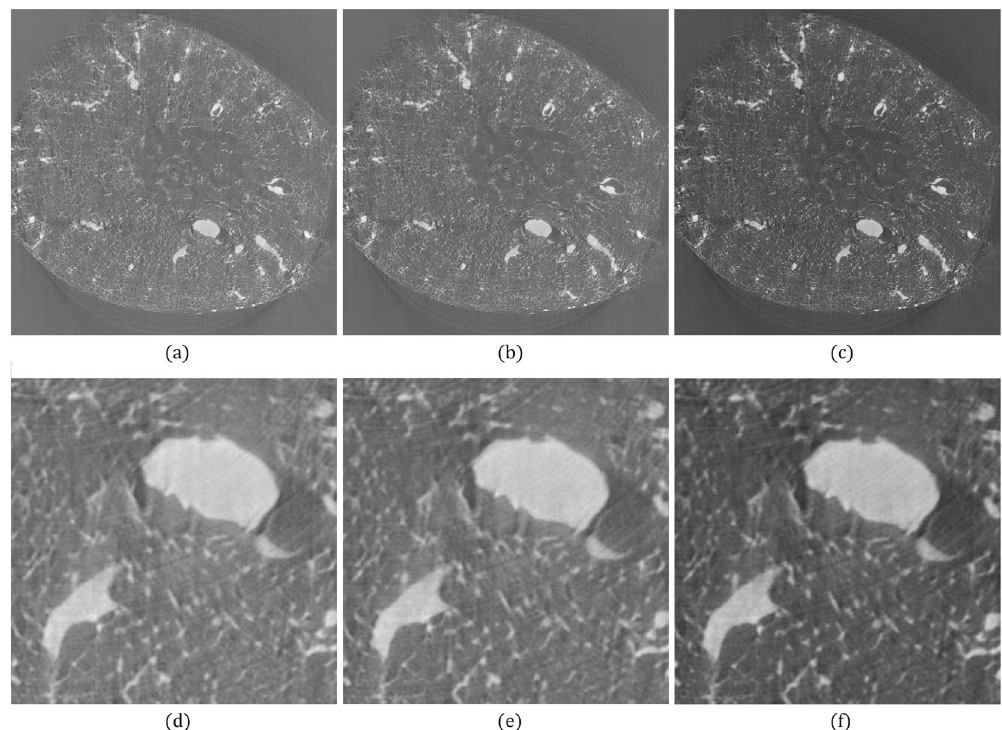
Figure 5. Reconstructed images of the same data in Fig. 4 after correcting errors. ( a ) Reconstruction result when δ B was corrected by the ENP method. ( b ) Reconstruction result when θ E was corrected by the FC method. ( c ) Reconstruction result when δ B and θ E were corrected by the proposed method. ( d – f ) Are the partial enlargements of the region in ( a – c )